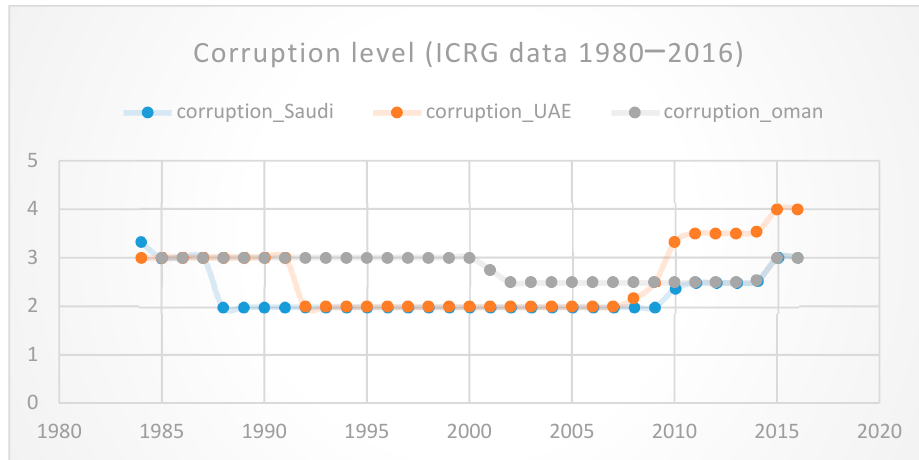
Figure 1. Corruption Level.